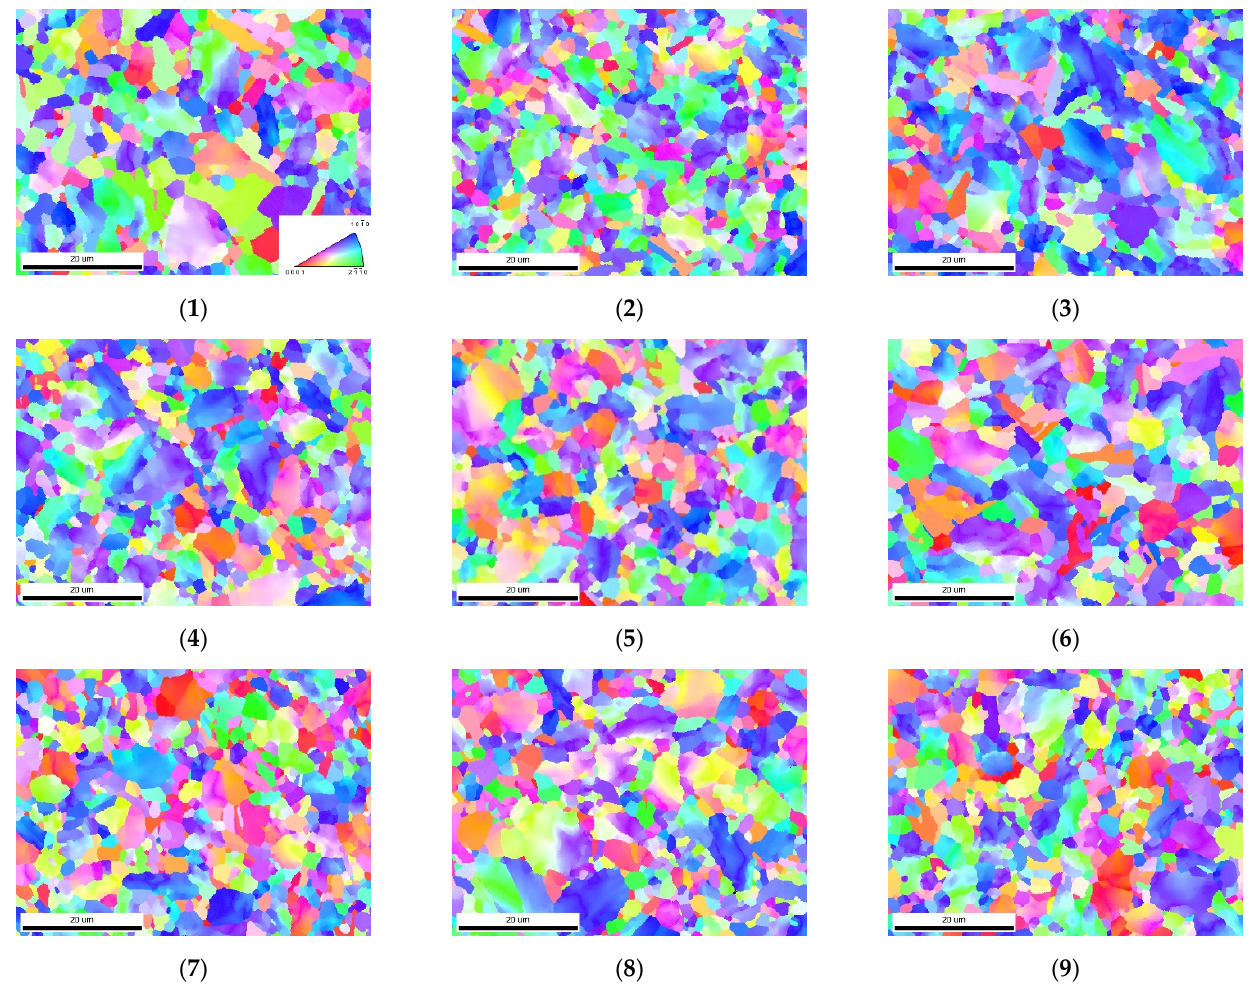
Figure 9. The grain orientation distribution maps of Ti-6Al-4V under different milling parameters.